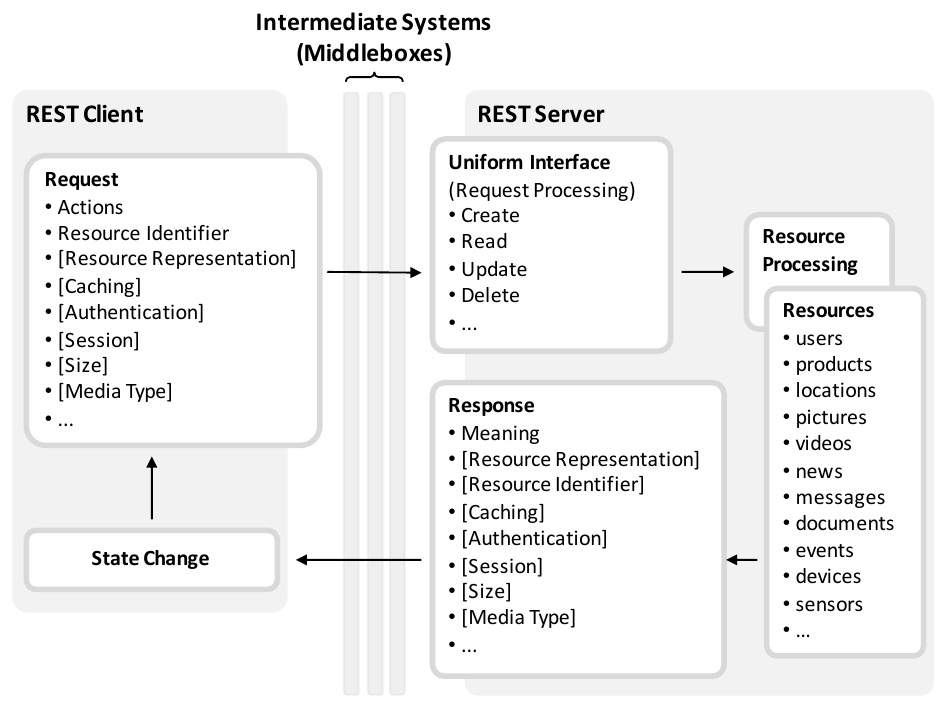
Figure 1. Overview of the representational state transfer (REST) constraints and principles (on the basis of